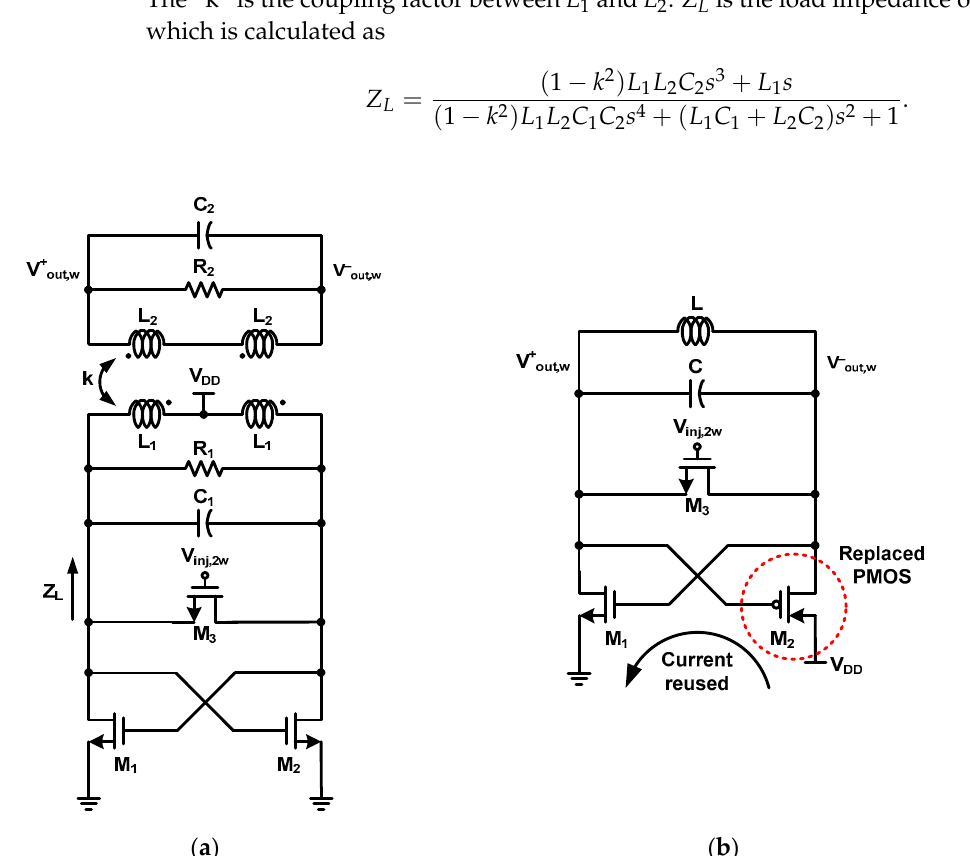
Figure 4. Schematic of ( a ) conventional cross-coupled pair ILFD with fourth-order resonator and ( b ) CR core-based ILFD.